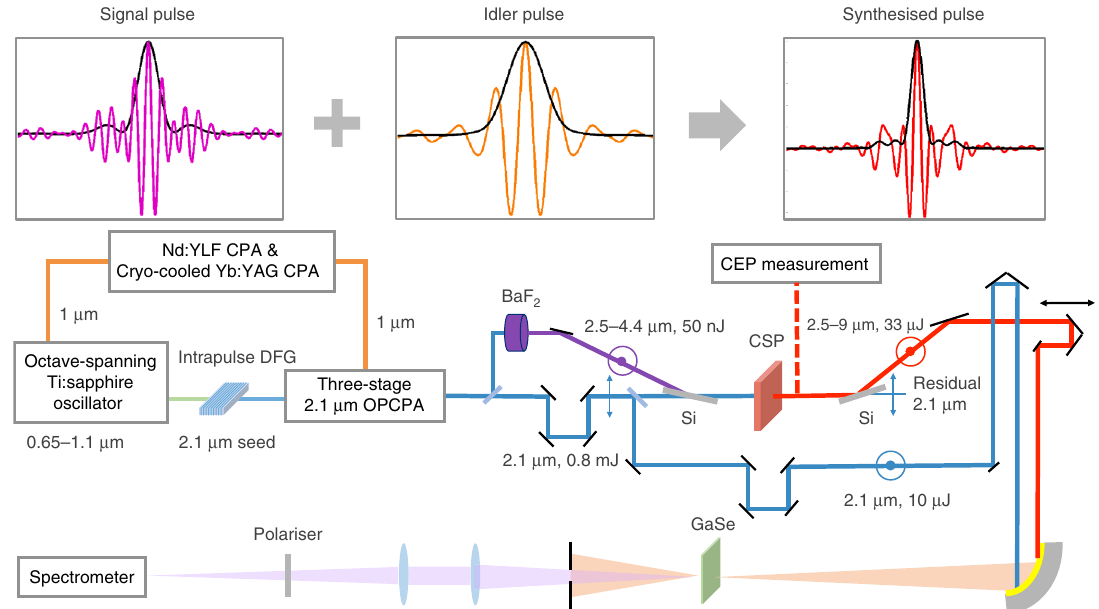
Fig. 1 Schematic of the high-energy phase-stable sub-cycle mid-infrared optical parametric ampli fi er. CEP carrier-envelope phase, CPA chirped-pulse ampli fi er, OPCPA optical parametric chirped-pulse ampli fi er. Polarisations of the beams are marked by double-headed arrows and concentric circles . The 300- µ m-thick Si wafers at Brewster angle are used as polarisation beam splitter and beam combiner to transmit the 2.1- µ m pump pulse and re fl ect the signal and idler pulses. The synthesised pulses and a branch of 2.1- µ m reference pulses are sent into cross-correlation frequency-resolved optical gating with a 30- µ m-thick GaSe nonlinear crystal. The synthesis of a sub-cycle mid-IR pulse from coherently combining the sub-2-cycle signal and idler pulses is shown conceptually on the top of the fi